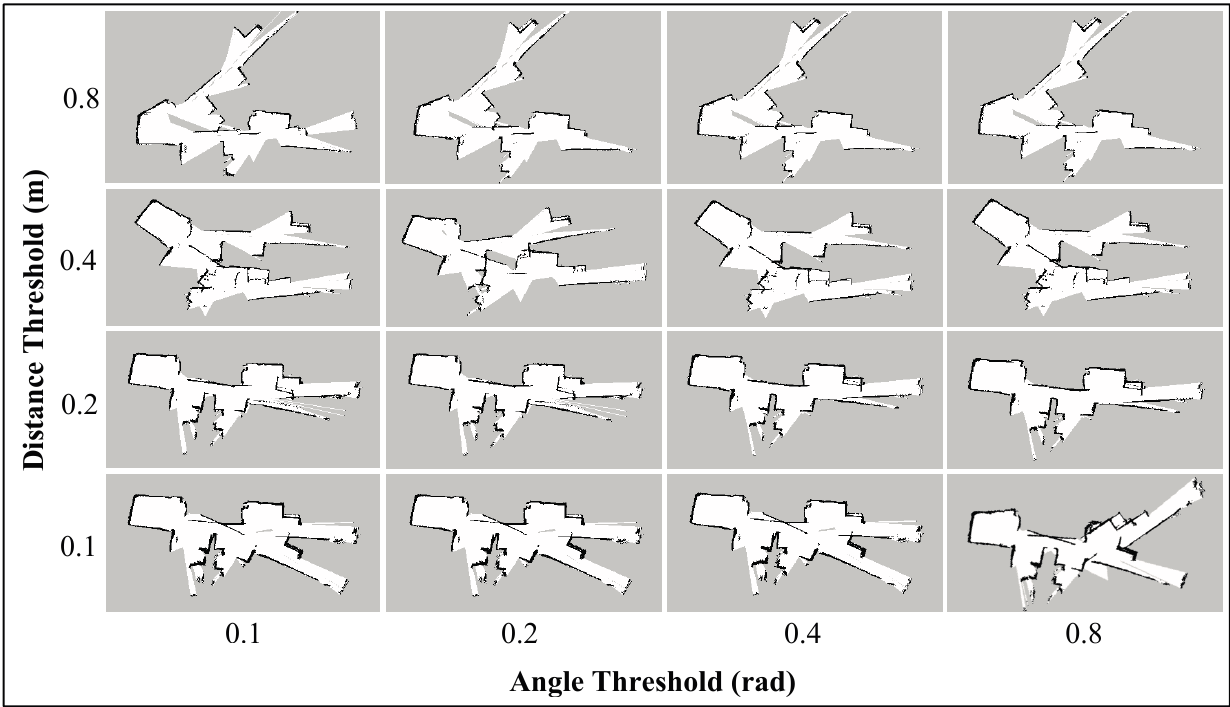
Figure 14. Corridor maps obtained using Hector SLAM technique with different combinations of Distance and Angle Threshold